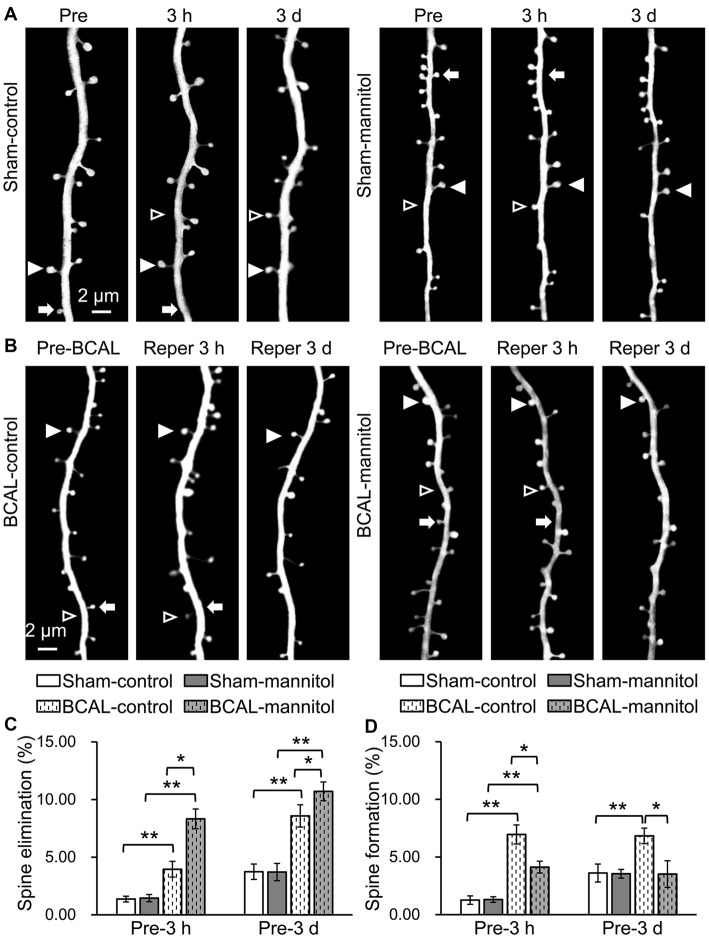
Mannitol-induced changes in spine formation and elimination following reperfusion after transient global cerebral ischemia. (A,B) Time-lapse imaging of dendritic structures showing spine formation or elimination in sham-control mice, sham-mannitol mice, BCAL-control mice and BCAL-mannitol mice. Open arrowheads, arrows and filled arrowheads indicate newly formed spines, eliminated spines and stable spines, respectively. (C) Spine elimination rate and (D) spine formation rate were significantly higher in BCAL-control than that of sham-control mice at 3 h and 3 days after reperfusion (n = 6 mice, each group. *p < 0.05 and **p < 0.01) and there were no significant changes in spine elimination rate and spine formation rate between sham-control mice and sham-mannitol mice at 3 h and 3 days (n = 6 mice, each group. p > 0.05). Note that spine elimination rate is significantly higher, but formation rate is significantly lower in BCAL-mannitol mice than that in BCAL-control mice at both 3 h and 3 days after reperfusion (n = 6 mice, each group. *p < 0.05 and **p < 0.01).